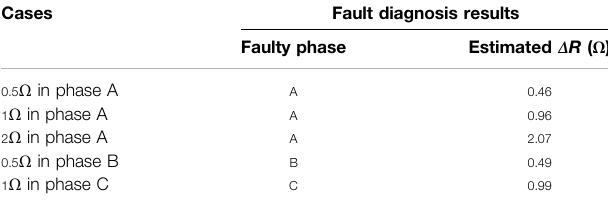
TABLE 2 | Experiment HRC diagnosis results.